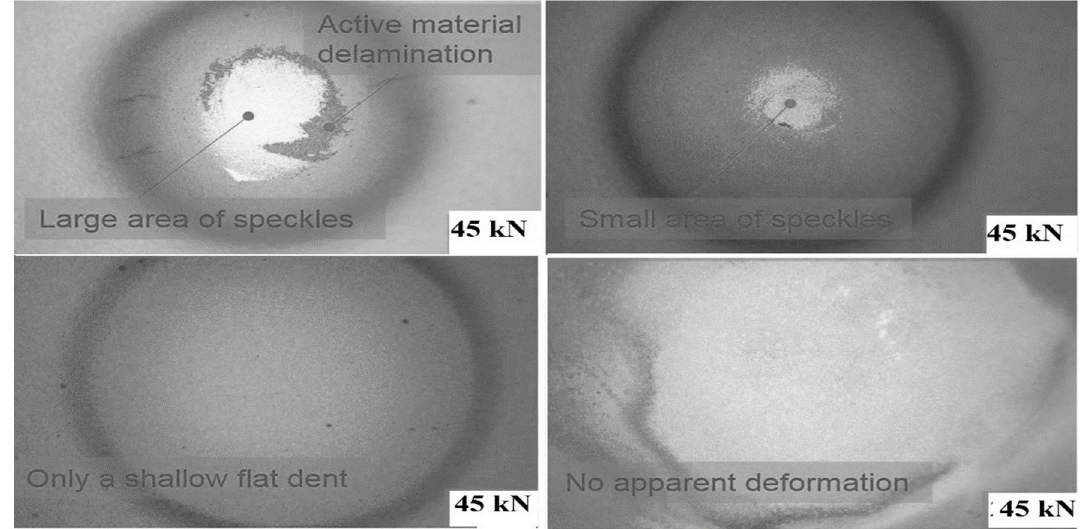
Figure 22. Post-mortem examination of the loaded area.